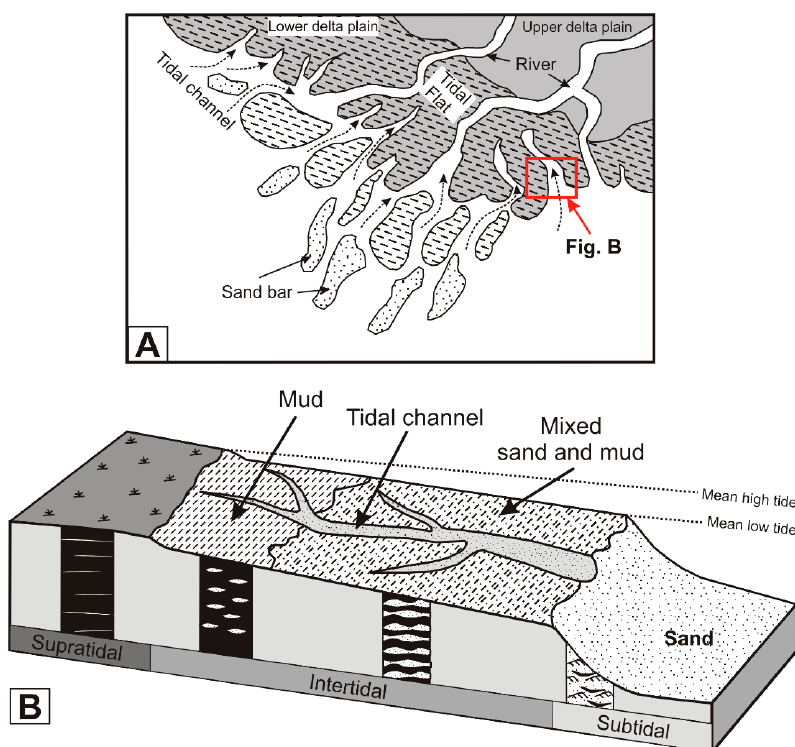
Figure 2. Schematic depositional models for the Miocene reservoir sediments deposited in the Hatia trough. ( A ) Aerial view of a tide dominated delta system and ( B ) schematic diagram showing different sub ‐ environments in a tidal flat setting. Diagrams are not drawn to scale.